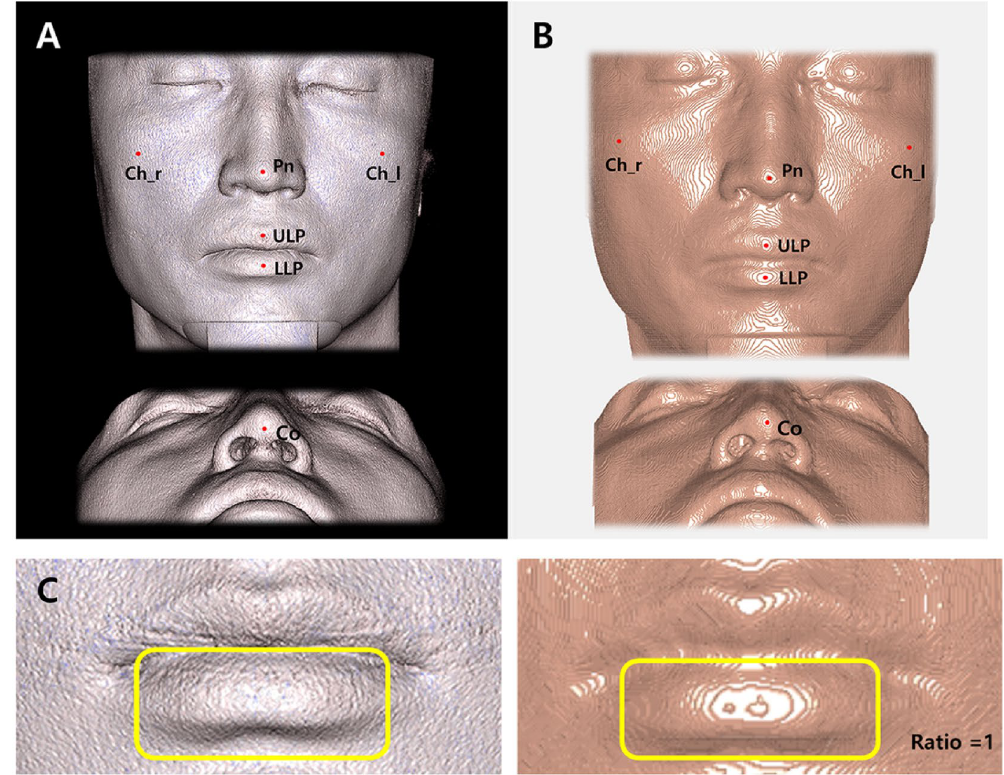
Figure 2. Schematic illustration of the landmarks used in this study. ( A ) Landmarks using the INVIVO6 software (Program A). ( B ) Landmarks using new homemade software (Program S). ( C ) Different lower lip images in the same patient (sample no. 023) according to program type. In Program A, detailed lower lip contour could not be observed. In Program S, contour lines with two tabletops with the same y-axis values were observed. The two most protruding parts could be accurately identified. Pn, Pronasale; Co, Columella; ULP, Upper lip point; LLP, Lower lip point; Ch_r, Cheek_right; Ch_l, Cheek_left.